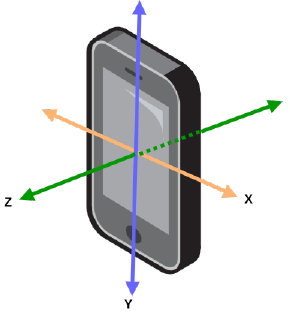
Figure 4. Representation of a smartphone axes.